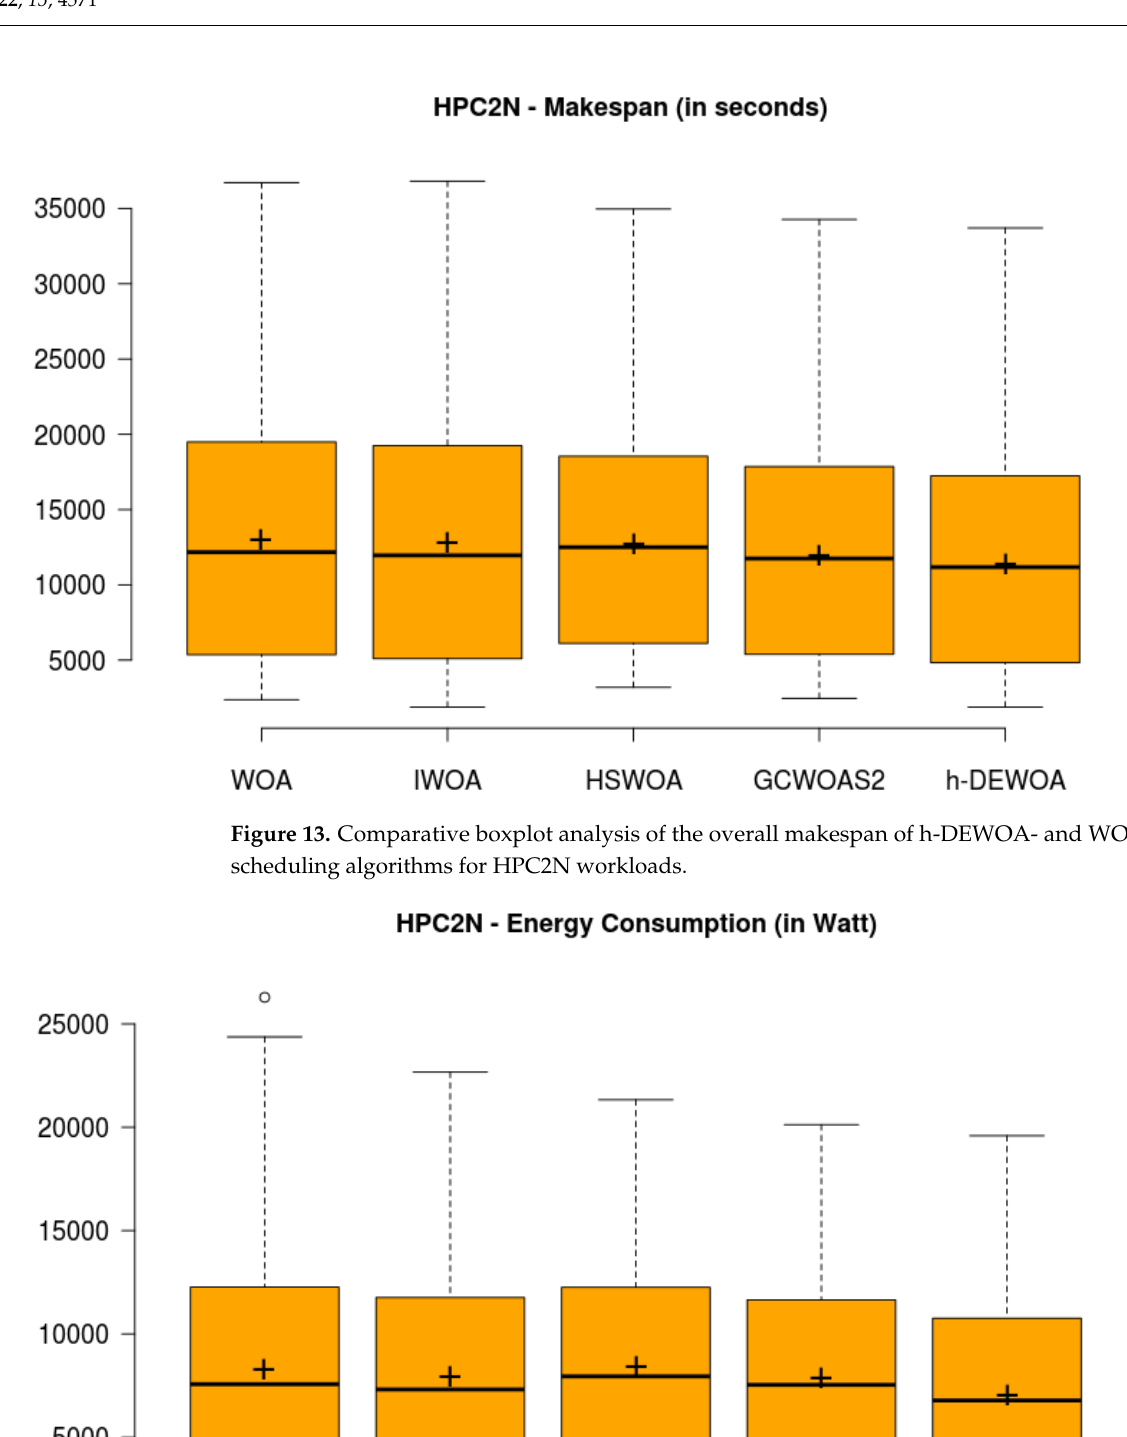
Figure 12. Comparative boxplot analysis of the overall energy consumption of h-DEWOA- and WOA-based scheduling algorithms for CEA-Curie workloads.